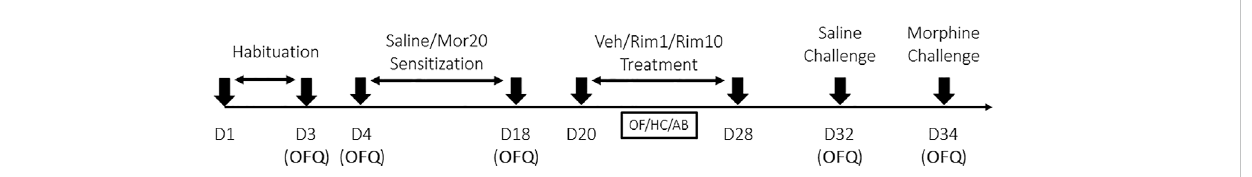
Design of experiments 1 – 3. OFQ, Open-Field Quanti fi cation of locomotor activity; Mor20, Morphine (20 mg/kg, i.p.); Veh, Vehicle (i.p.); Rim1, Rimonabant (1 mg/kg, i.p.); Rim10, Rimonabant (10 mg/kg, i.p.); OF, Open- fi eld (drug-associated environment); HC, home-cage; AB, activity box (novel environment). Sensitization: every other day treatment with morphine or saline. Treatment: daily treatment with vehicle or rimonabant in the open- fi eld (Experiment 1), in the home-cage (Experiment 2) or in the activity box (Experiment